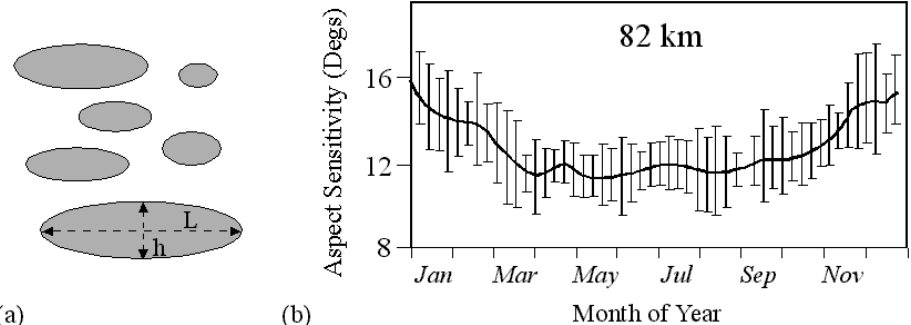
Fig. 8. (a) Illustration of the representation of atmospheric scatterers within a patch of turbulence. (b) Aspect sensitivity parameter θ s as a function of the month of the year for a 2MHz radar detecting scatter from an 82 km altitude in the mesosphere (from Lesicar and Hocking,